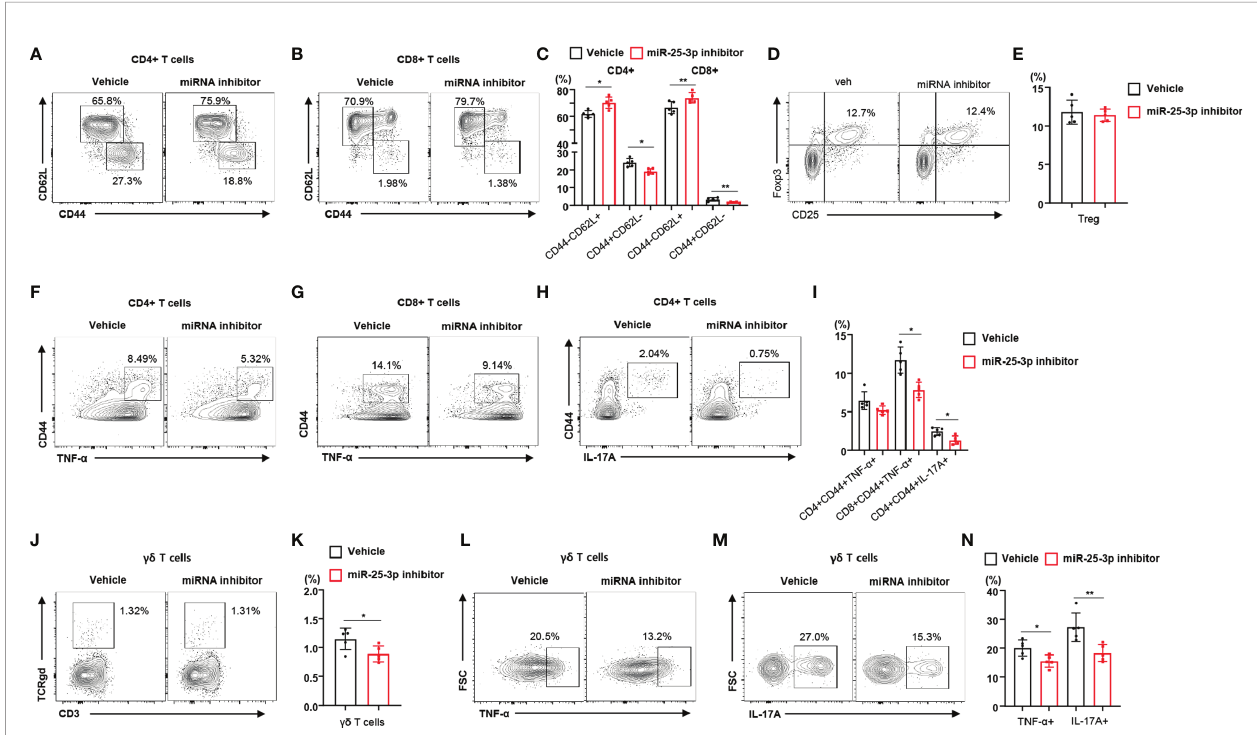
FIGURE 3 | Inhibition of miR-25-3p attenuates periodontal in fl ammation in male mice with diet-induced obesity and periodontitis. (A – C) Representative fl ow cytometry plots and percentages of CD44 + CD62L − and CD44 − CD62L − cells in the CD4 + and CD8 + T cell populations from submandibular lymph nodes of either vehicle-treated (n = 5) or miR-25-3p inhibitor-treated (n = 5) male mice with periodontitis 9 days after ligature placement. (D, E) Representative fl ow cytometry plots and frequencies of CD4 + CD25 + Foxp3 + regulatory T cells in HFD-fed mice treated with either miR-25-3p inhibitor or vehicle. (F – I) Percentages of TNF- a - or IL-17A-producing cells in the population of CD4 + or CD8 + T cells in periodontitis-induced mice treated with either miR-25-3p inhibitor or vehicle. (J, K) Percentages of gd T cells in submandibular lymph nodes of periodontitis-induced mice treated with either miR-25-3p inhibitor or vehicle. (L – N) Representative fl ow cytometry plots and percentages of TNF- a - or IL-17A-producing cells in the population of gd T cells from periodontitis-induced mice treated with either miR-25-3p inhibitor or vehicle. Data represent mean values of more than three independent experiments. Data are expressed as the mean ± SEM. *p < 0.05, **p < 0.01 (C, E, I, K, N) , two ‐ tailed t